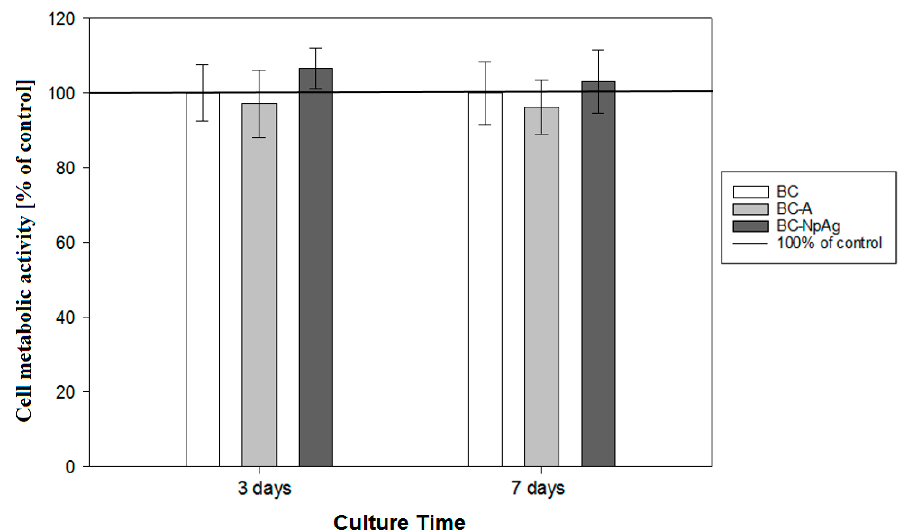
Figure 8. MC3T3-E1 metabolic activity on the surface of BC coatings at day 3 and 7 culture. Results are expressed as % change in cell metabolic activity on modified bone cements compared to the cell metabolic activity on pure bone cement, assumed as 100% (n = 3; mean ± SD; *significantly different from unmodified bone cement—p < 0.05).